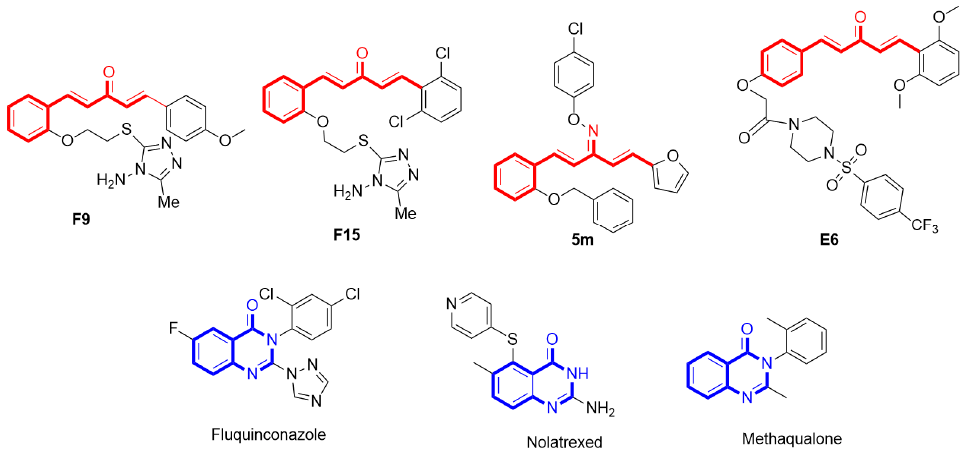
Figure 1. Reported active structures containing 1,4-pentadiene-3-one and quinazolinone fragments.